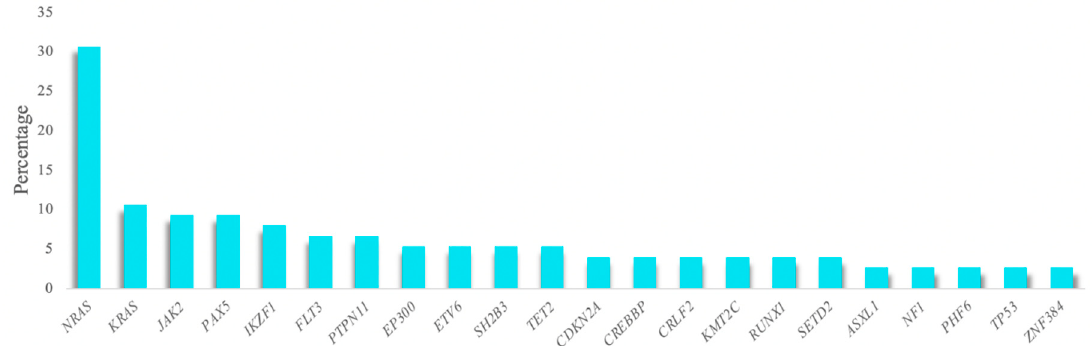
Figure 1. Genes most frequently mutated in the patient series. The histogram shows the genes detected in more than 2% of the patient series.